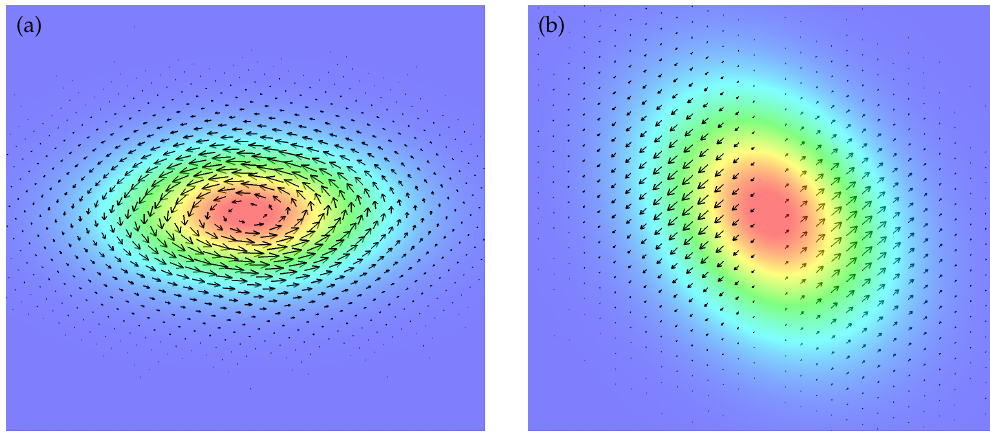
Figure 1. ( a ) xy - and ( b ) yz -cross-sections of a right circularly polarized Gaussian